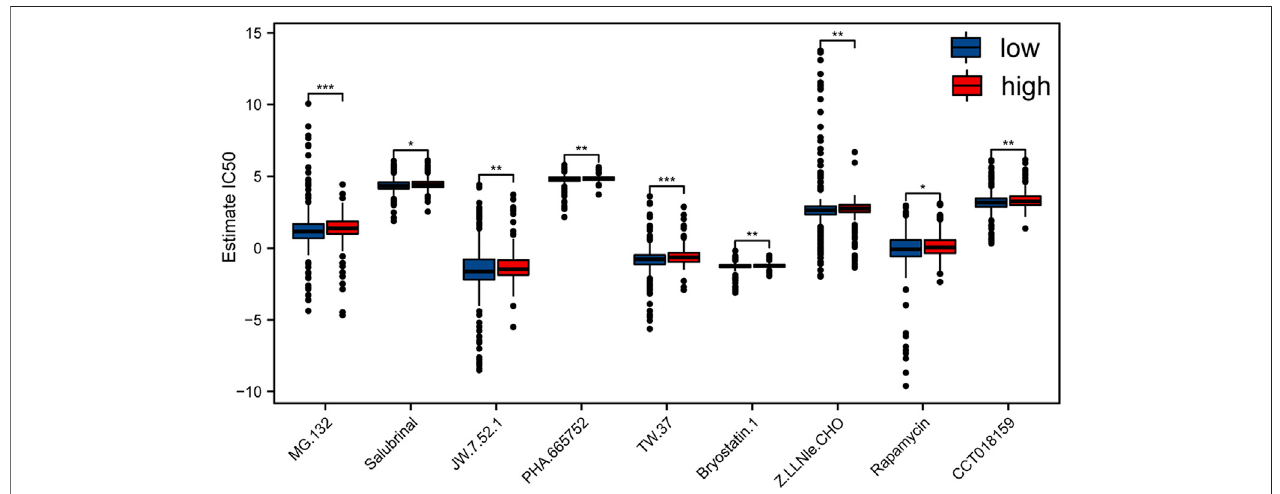
FIGURE 6 | Evaluation of the sensitivity to different chemotherapeutics and small-molecule anticancer drugs with risk score of m6A-related lncRNAs according to the GDSC database.